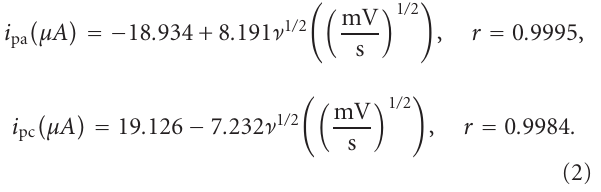
Figure 1: (a) Cyclic voltammograms (30 cycles) of CuHCF films at the glassy carbon electrode recorded in 0.25 M KH 2 PO 3 + 0.125mM CuSO 4 + 0.125mM K 3 [Fe(CN) 6 ] solutions with Ag/AgCl reference electrode. Scan rate: 50mV/s. Curves from inner to outer correspond to the 1th, 5th, 15th, 20th, 25th, and 30th cycles, respectively. (b) XRD pattern of the CuHCF film. (c) SEM image of copper hexacyanoferrates nanoparticles (CuHCFNPs). (d) Comparative cyclic voltammogramsof the CuHCF-modified GCE in (A) 0.1 M NH 4 NO 3 , (B) 0.1 M LiNO 3 , (C) 0.1 M KNO 3 , and (D) 0.1 M NaNO 3 solutions. Scan rate: